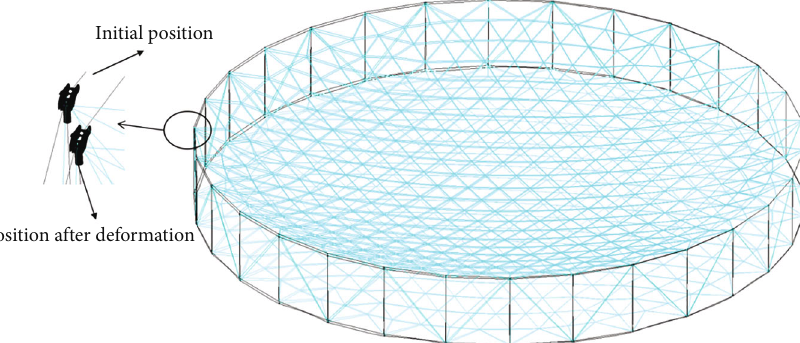
Figure 2: The deformation of the ring truss under the cable mesh